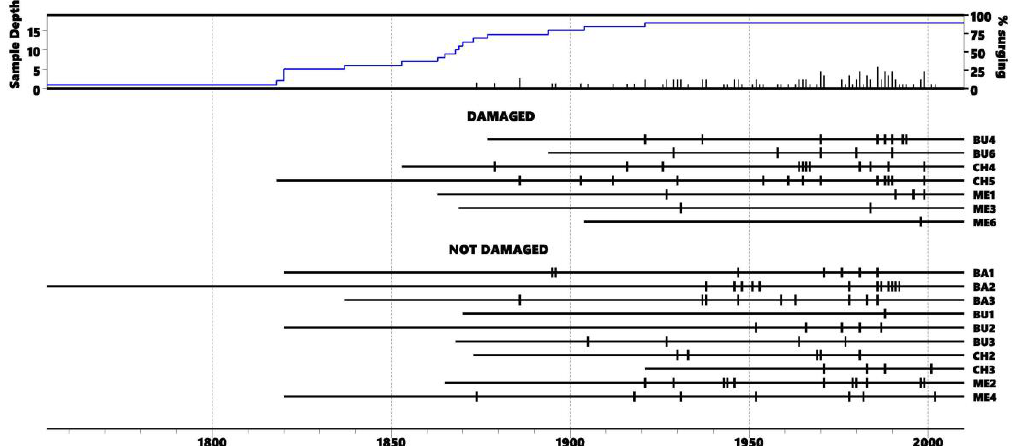
Figure 3. Tree-ring reconstruction of single-tree releases in storm-damaged and -undamaged Picea schrenkiana stands in southeast Kazakhstan. The chart records events in which a growth release initiated in a single tree in a single year on a 0.04-ha plot, by site, with each tick mark representing a growth release of at least 50% lasting 10 or more years. BA is Bolshaya Almatinka, BU is Butakovka Valley, CH is Chimbulak, and ME is Medeu Ski Valley.